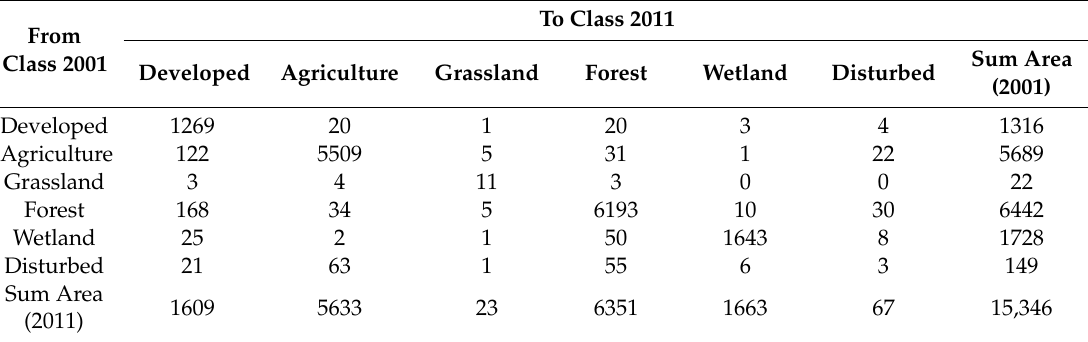
Table 1. Main area (km 2 ) LULC matrix comparing LCMAP (2001–2011).